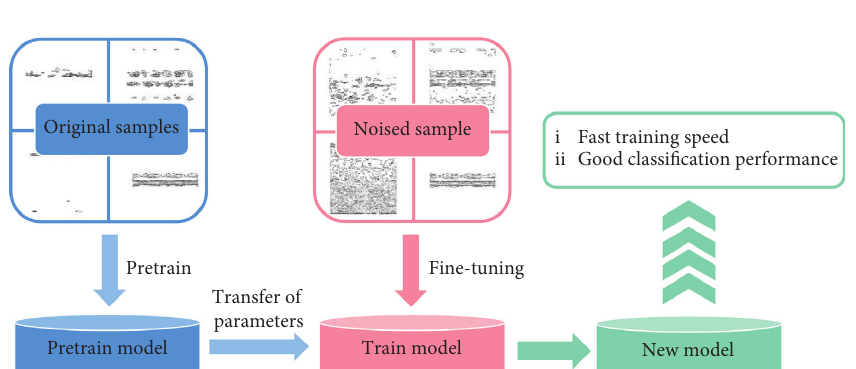
Figure 14: Parameter transfer